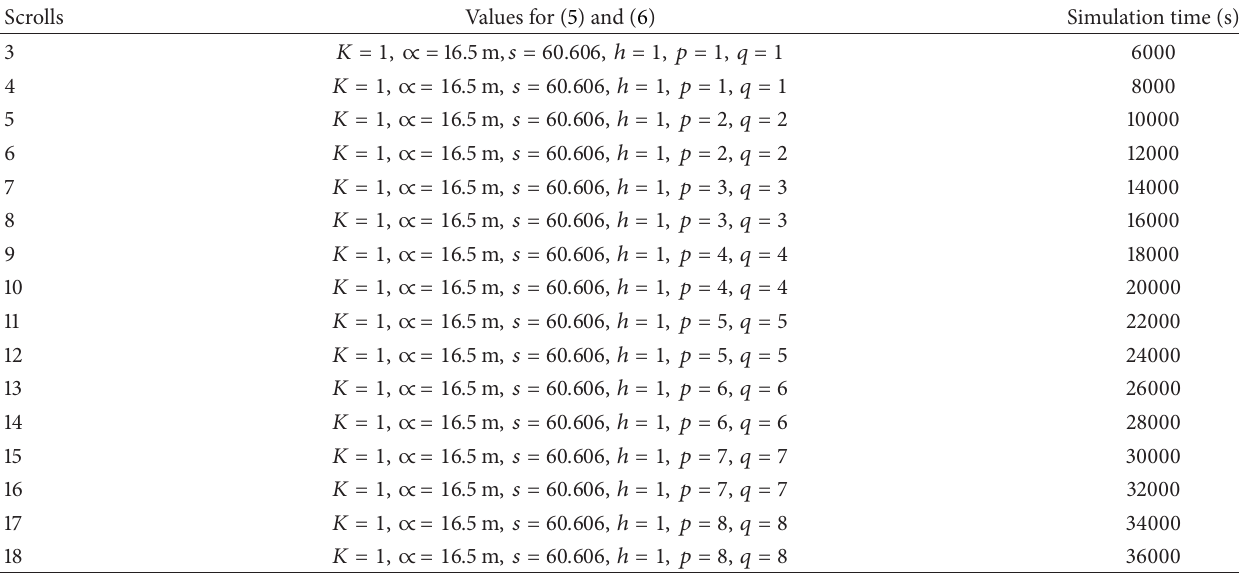
Table 2: Values for generating from 3 to 18